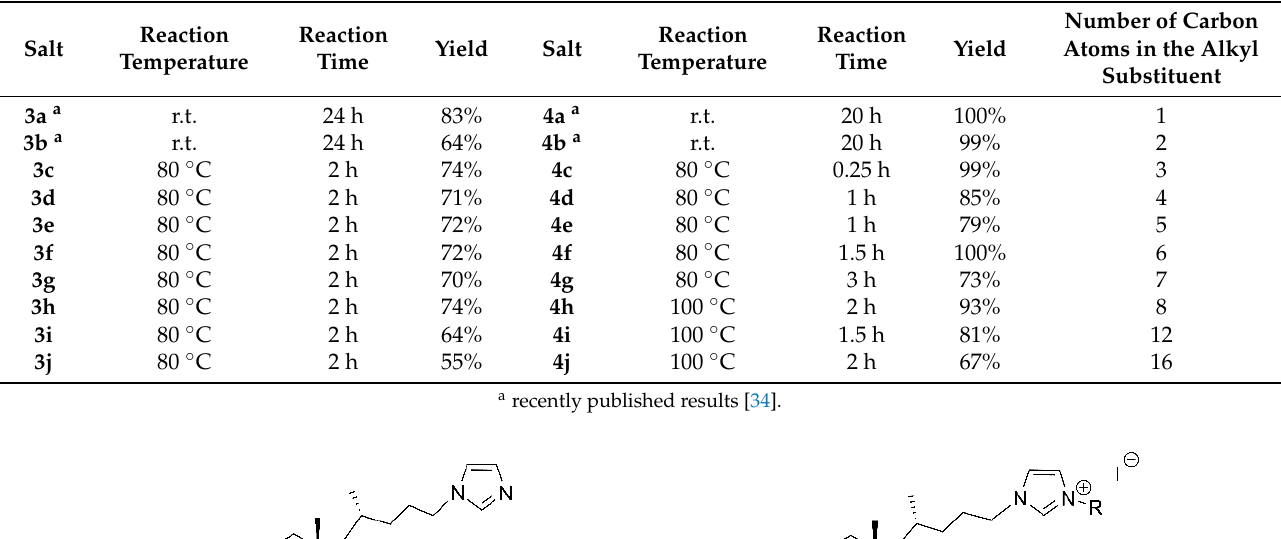
Table 1. Synthesis of steroid-based salts.